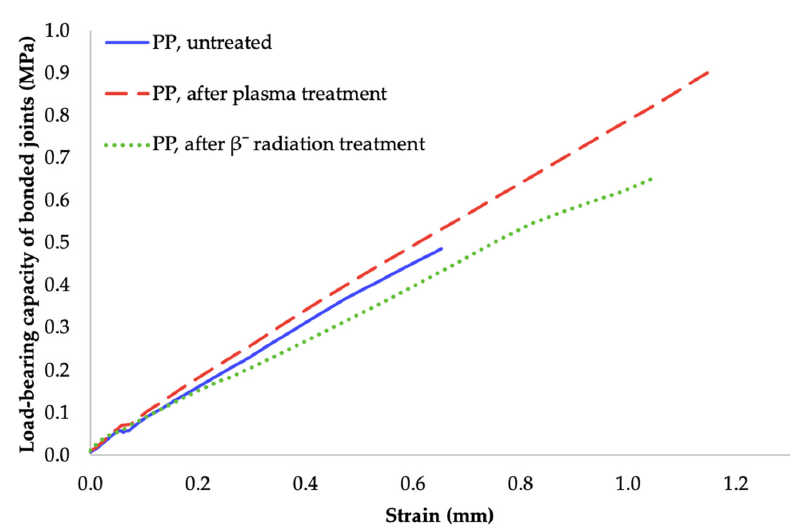
Figure 12. Dependence of bonded-joint load-bearing capacity of adhered joints on strain (two- component acrylate adhesive). component acrylate